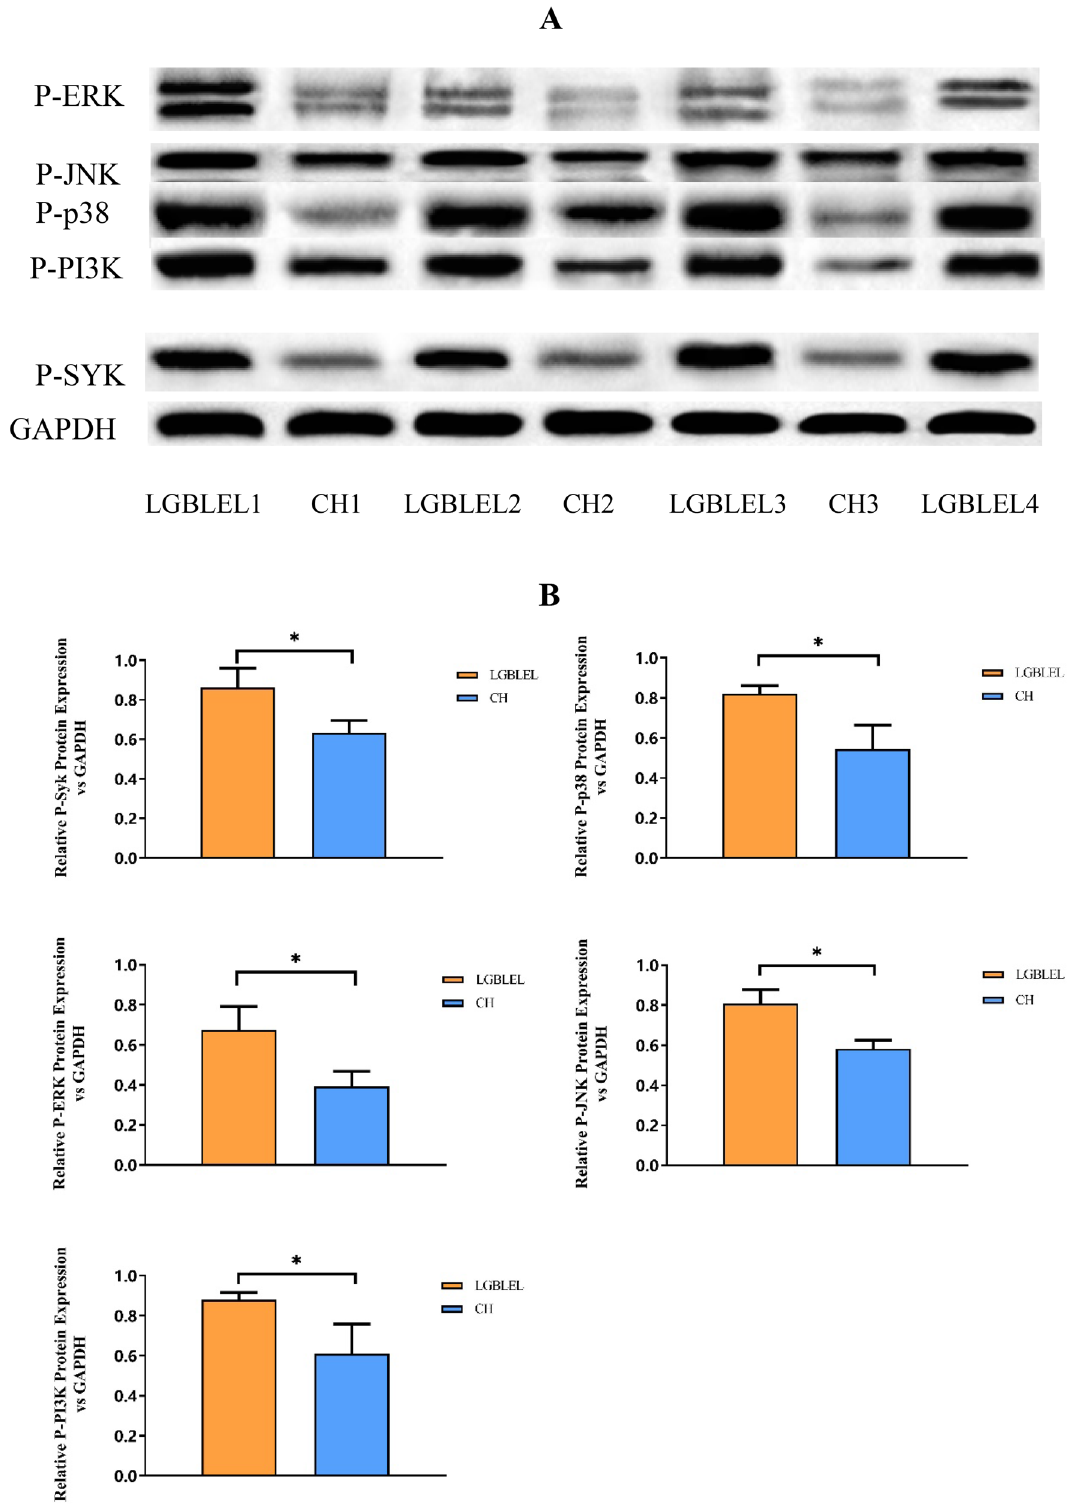
Figure 5. Comparison of protein immunoblotting and protein content between LGBLEL and orbital CH. ( A ) Western blotting showed higher expression of proteins related to the FcεRI signaling pathway in LGBLEL than in orbital CH. ( B ) The protein contents of p-SYK, p-p38, p-JNK, p-PI3K, and p-ERK were significantly higher than in orbital CH (P = 0.0169; P = 0.0074; P = 0.0046; P = 0.0157; P = 0.0156,